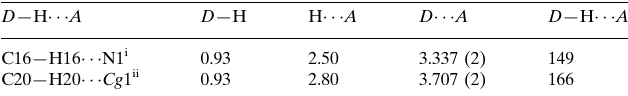
Hydrogen-bond geometry (A˚ , (cid:2) ). Cg 1 is the centroid of the C15–C20 phenyl